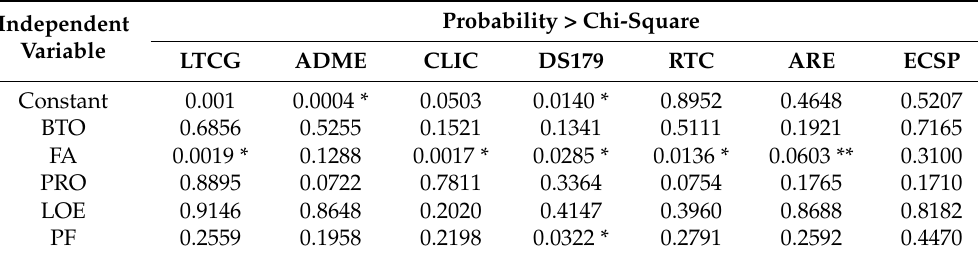
Table 5. Summary of Use Models for the Seven Tax